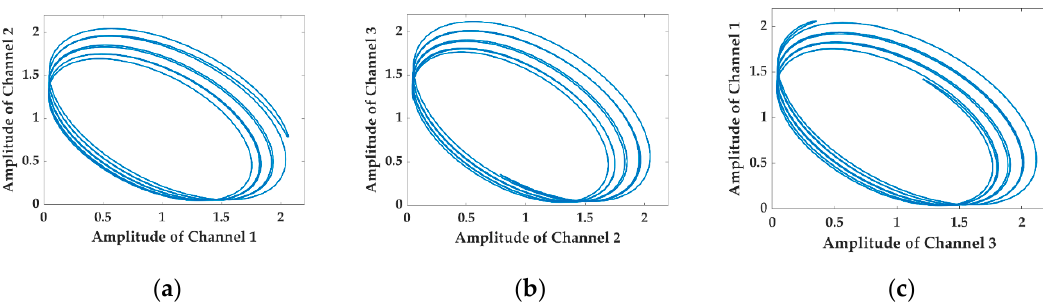
Figure 2. Numerical results obtained from Equation (2), in which the AAM of the light source is taken into consideration: fail to maintain the elliptic line anymore. ( a ) The LF drawn with Channel 1 and Channel 2; ( b ) the LF drawn with Channel 2 and Channel 3; ( c ) the LF drawn with Channel 3 and Channel 1.